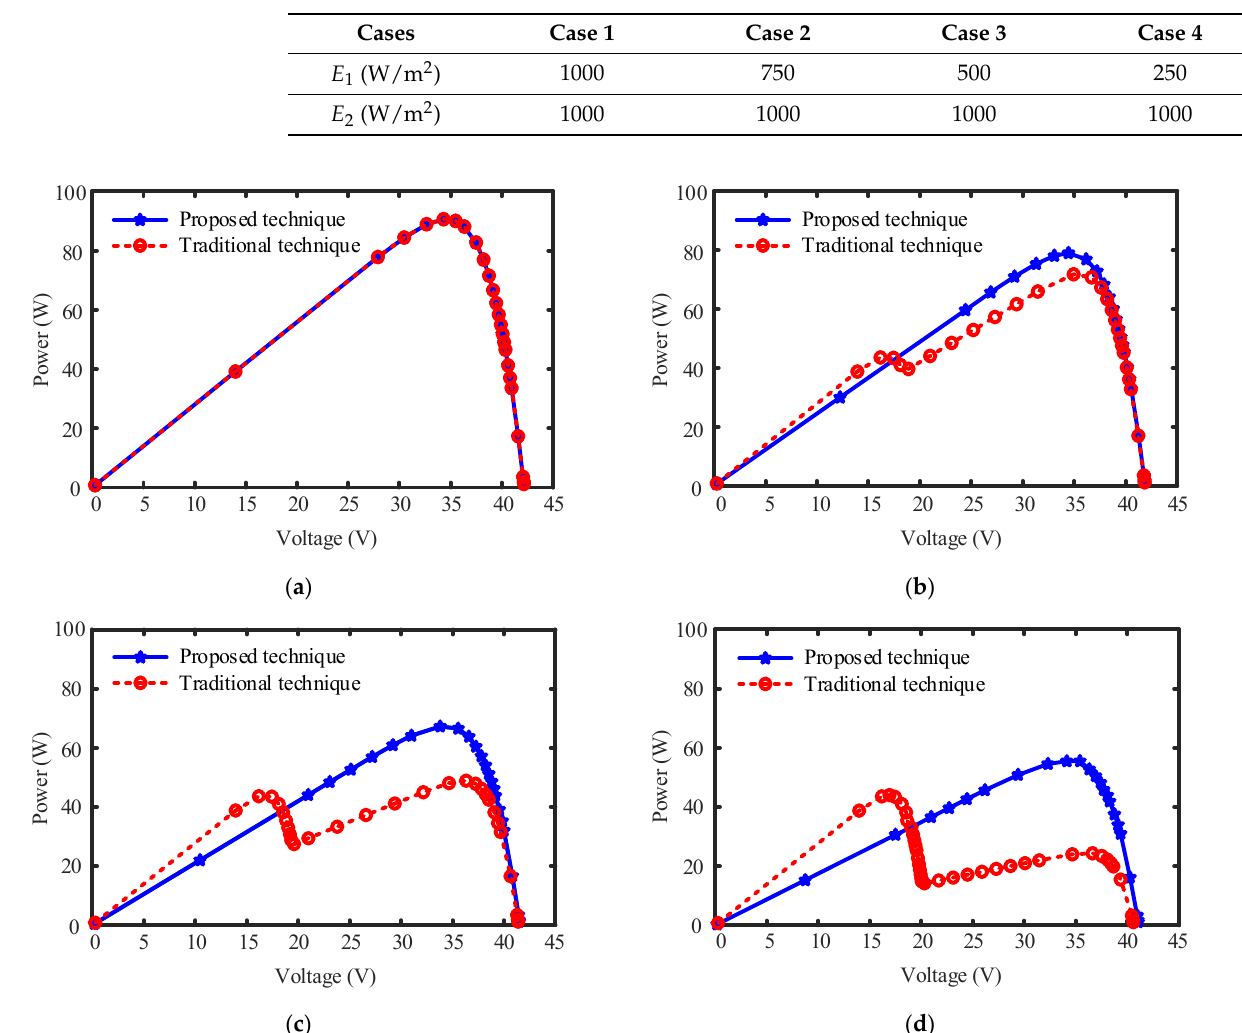
Figure 9. P-V characteristics for the proposed topology under mismatch cases given in Table 2 for proposed DPP and traditional bypass diode technique ( a ) Case 1, ( b ) Case 2, ( c ) Case 3, ( d ) Case 4.